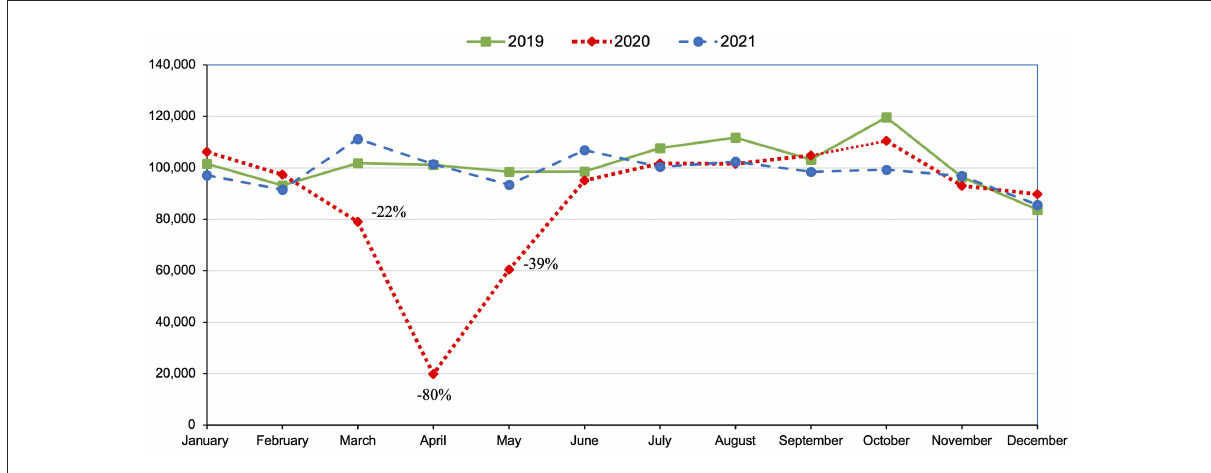
FIGURE1 Number of cats and dogs spayed or neutered per month at 212 spay-neuter clinics in the US during baseline year 2019, and COVID-19 pandemic years 2020 and 2021.